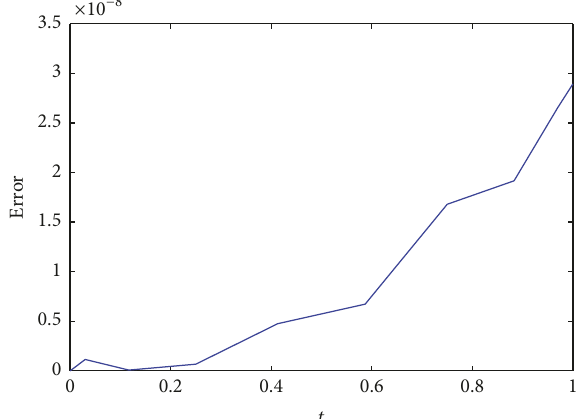
Figure 4: The valid region ℎ for the explicit spectral PIM when 𝑁 = 10 for Example 2.